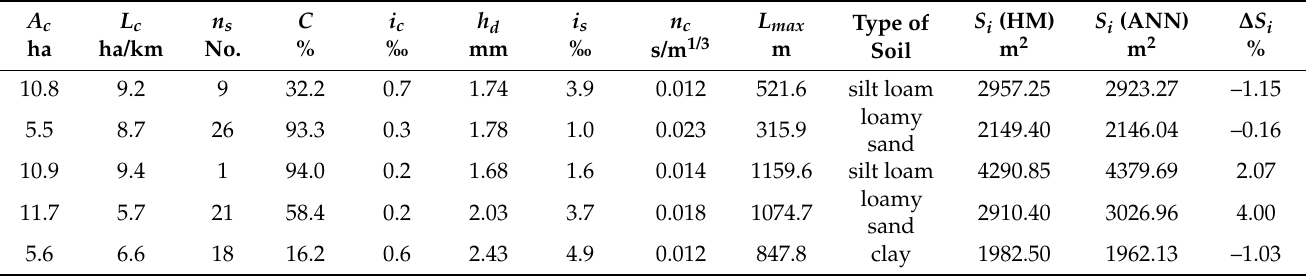
Table A2. Comparison of the required areas of the fully water-saturated infiltration basin ( S i ) generated for a random combination of input parameters from the MLP 12-9-1 artificial neural network (ANN) and those obtained from hydrodynamic simulations (HM) (designations as in Figure